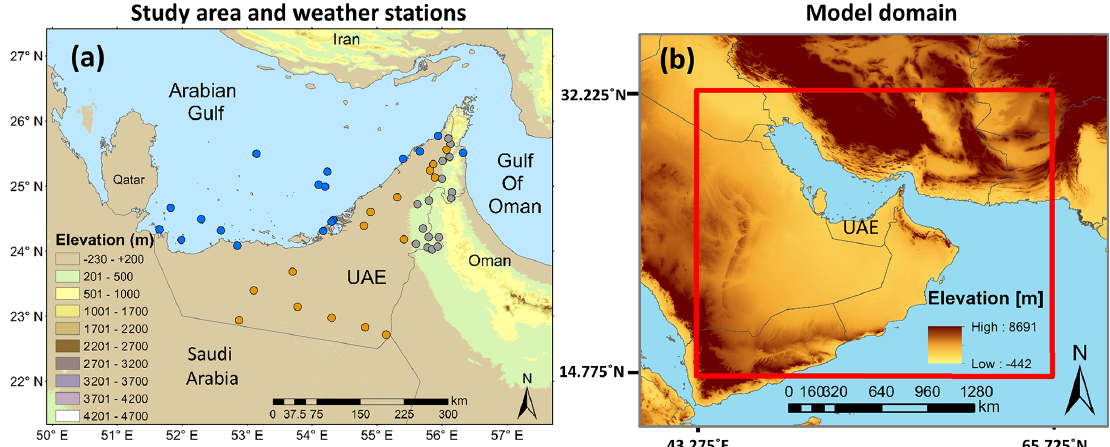
Figure 1. Panel (a) is a close-up of the study area overlaid with classified topography and 48 UAE surface weather stations used for verification of WRF. Weather data were provided by the National Centre for Meteorology (NCM) in the UAE. The weather stations were grouped into geophysical regions for statistical analysis. The 17 blue dots indicate coastal and marine stations (criteria – on islands or within 5km from coastline). The 16 grey dots are mountain stations (criteria – any station ≥ 200ma.s.l. and > 5km from coast). The 15 orange dots are inland desert stations (criteria – all remaining stations). Panel (b) is the 900 × 700 grid cell model domain ( (cid:49)x 2 . 7km, 2430 × 1890km). The four corner model grid cells are located at 14.775 ◦ N, 32.225 ◦ N, 43.275 ◦ E, and 65.725 ◦